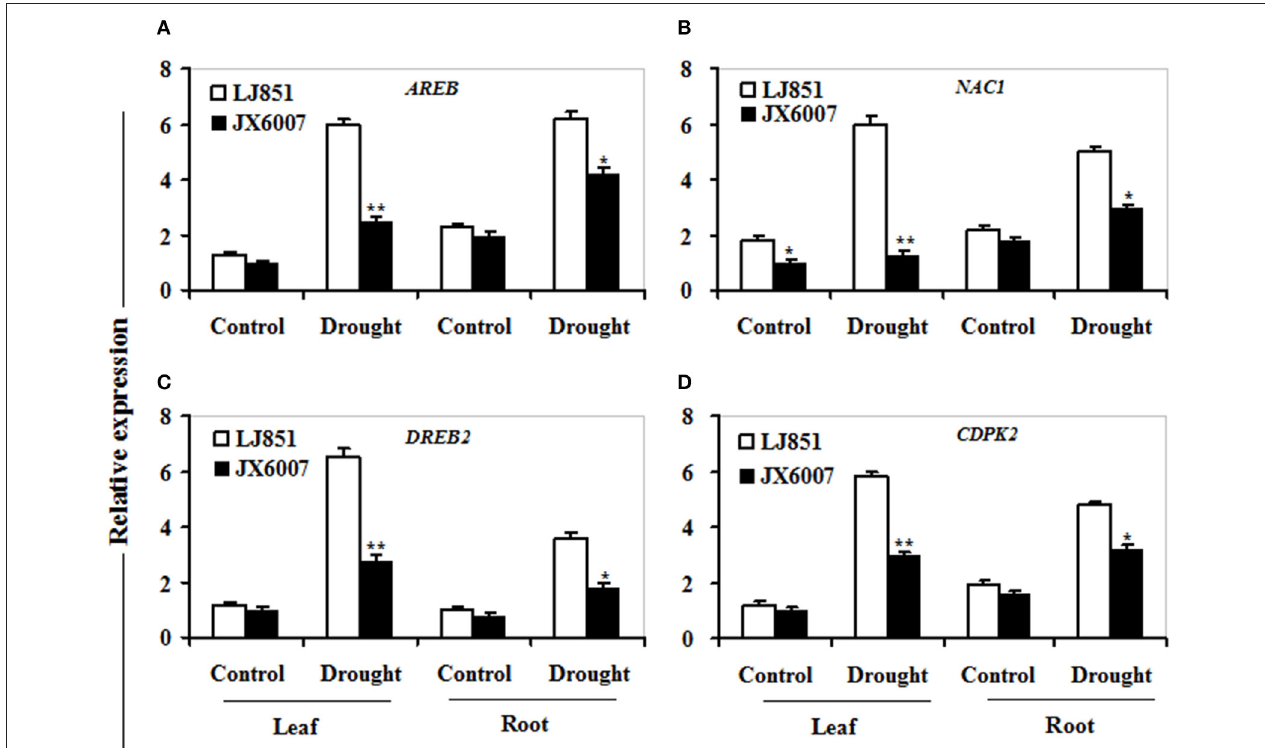
FIGURE 9 | Transcriptional expression of signaling and transcription factor genes in leaf and root under drought stress. RNA was extracted from 10-day stressed leaves and roots and reverse-transcribed to synthesize cDNA, which was used for qPCR analysis with primers specific for four genes AREB (A) , NAC1 (B) , DREB2 (C) , and CDPK2 (D) . Data represented means ± SE of three biological replicates. Bar indicates SE. ** t -test, with P < 0.01; * t -test, with P < 0.05.